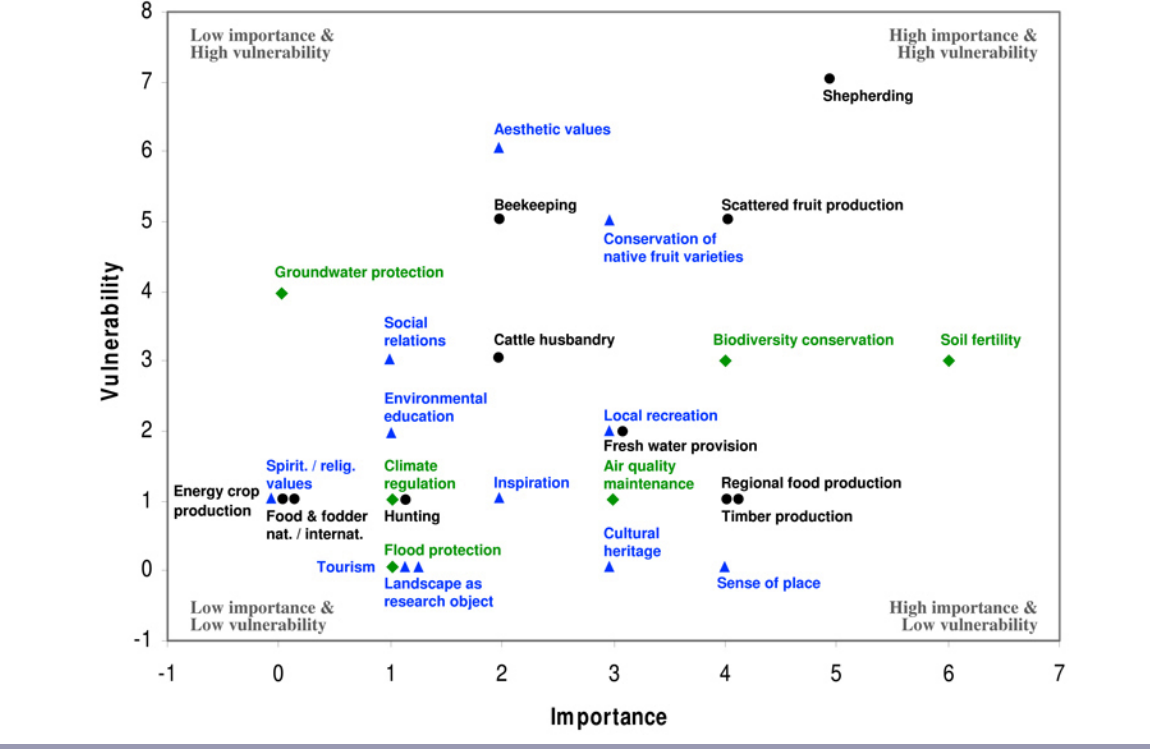
Fig. 7 . Perceived importance and vulnerability of ecosystem services provided by local cultural landscapes, over the discussed time period. Black indicates predominantly provisioning services, green represents regulating services, and blue represents cultural services (modified from Palomo et al. 2011).